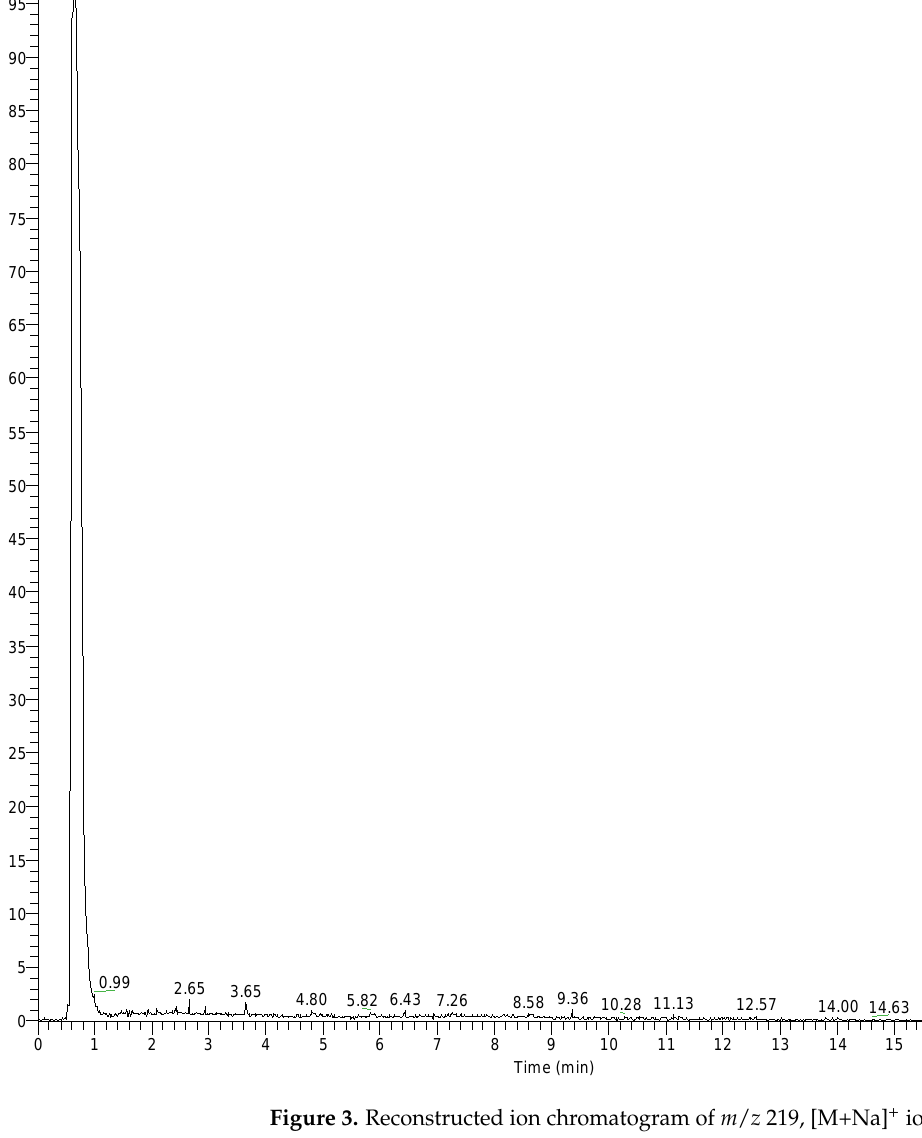
Figure 3. Reconstructed ion chromatogram of m / z 219, [M+Na] + ions corresponding to gluconic acid from Manuka honey sample. Table 1. Linear ranges, linear equation, the coefficient of determination (R2), and limit of detection (LOD) and quantification (LOQ) for gluconic